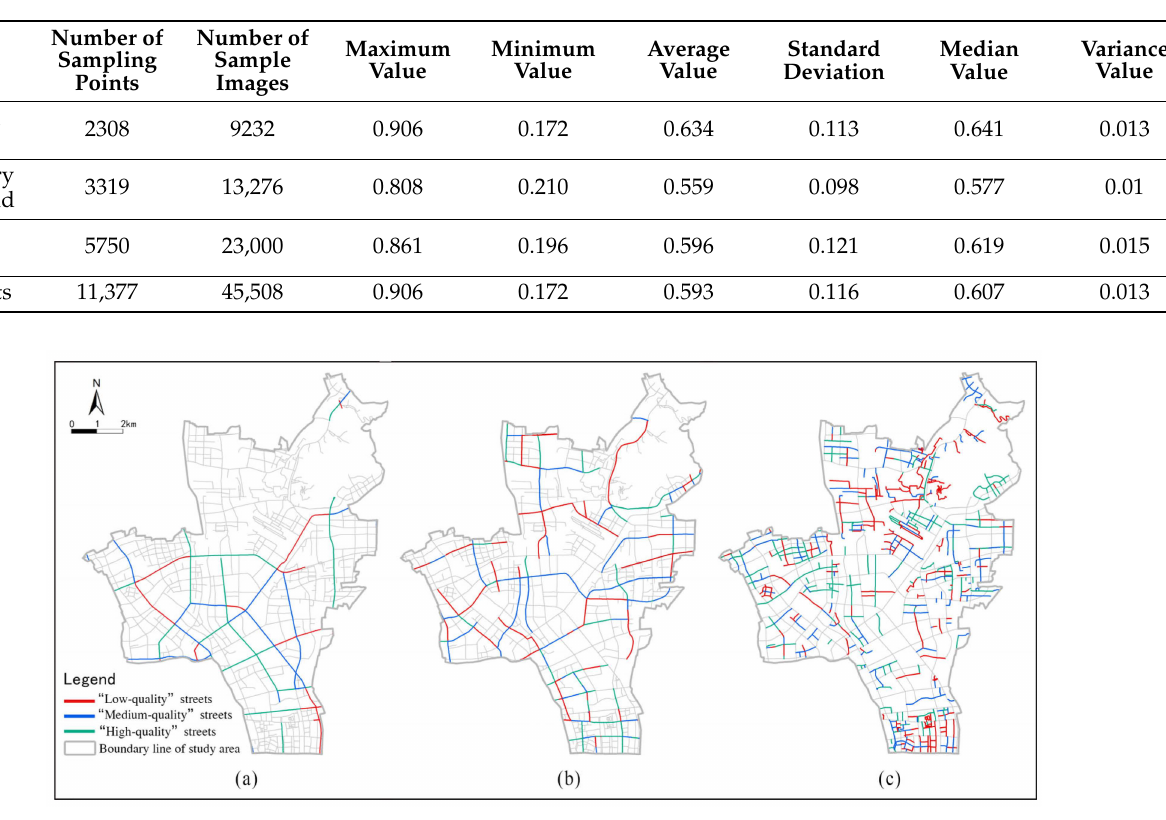
Table 3. Basic information of street spatial quality measurement results.